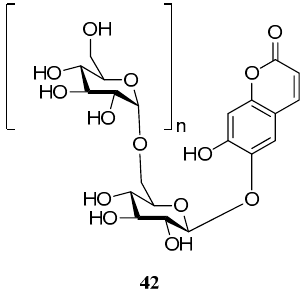
Figure 4. Structure of polysaccharide glycosides of esculetin.